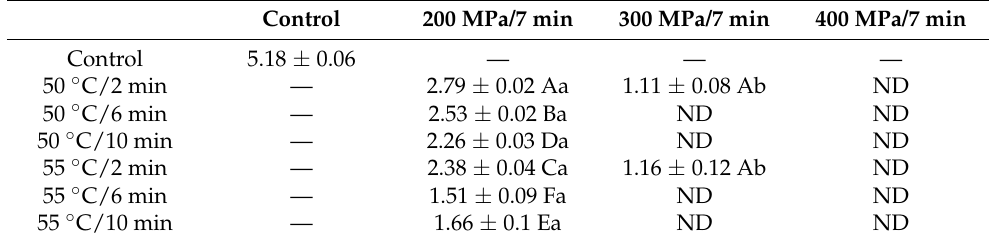
Table 1. Effects of TAHHP processing on the total aerobic counts in aronia